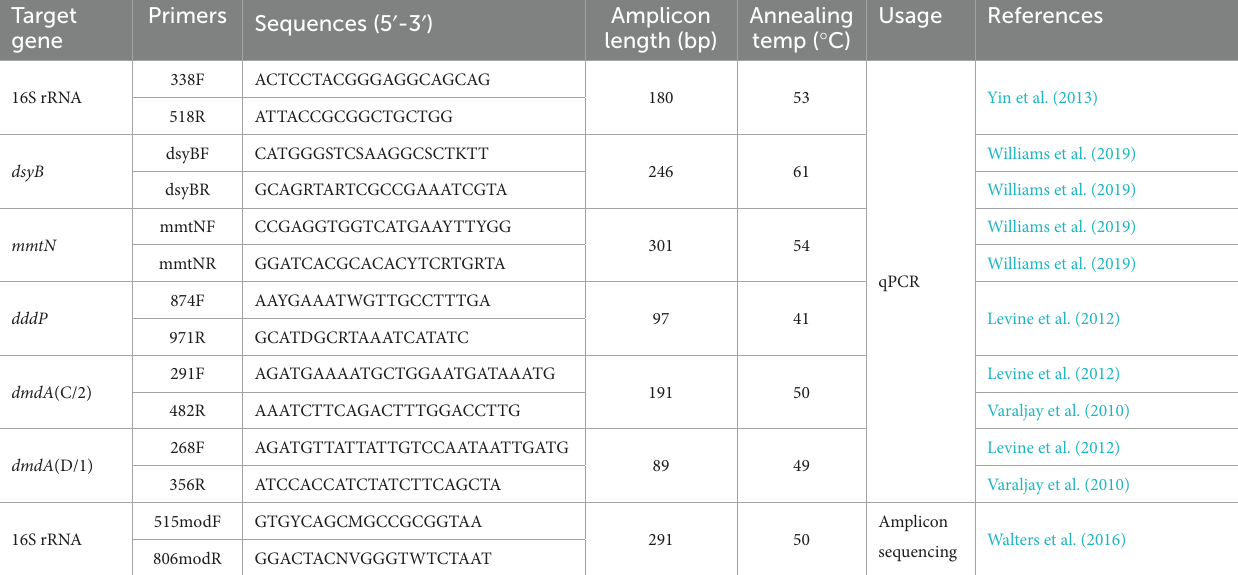
TABLE 1 Primers and amplification conditions for qPCR detection and high-through sequencing of bacteria. Target